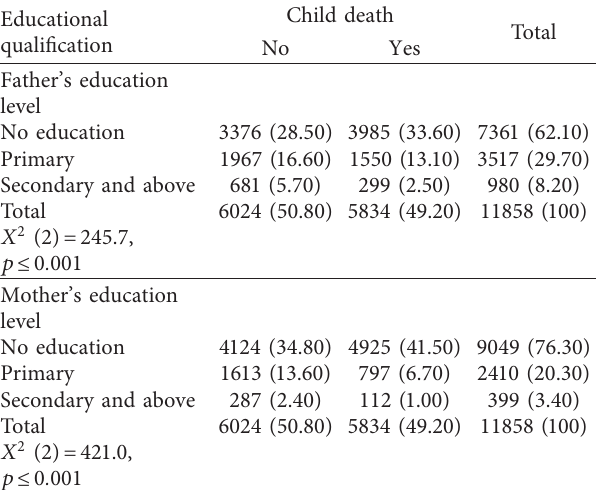
Table 3: Geopolitical regions on child mortality. Regions